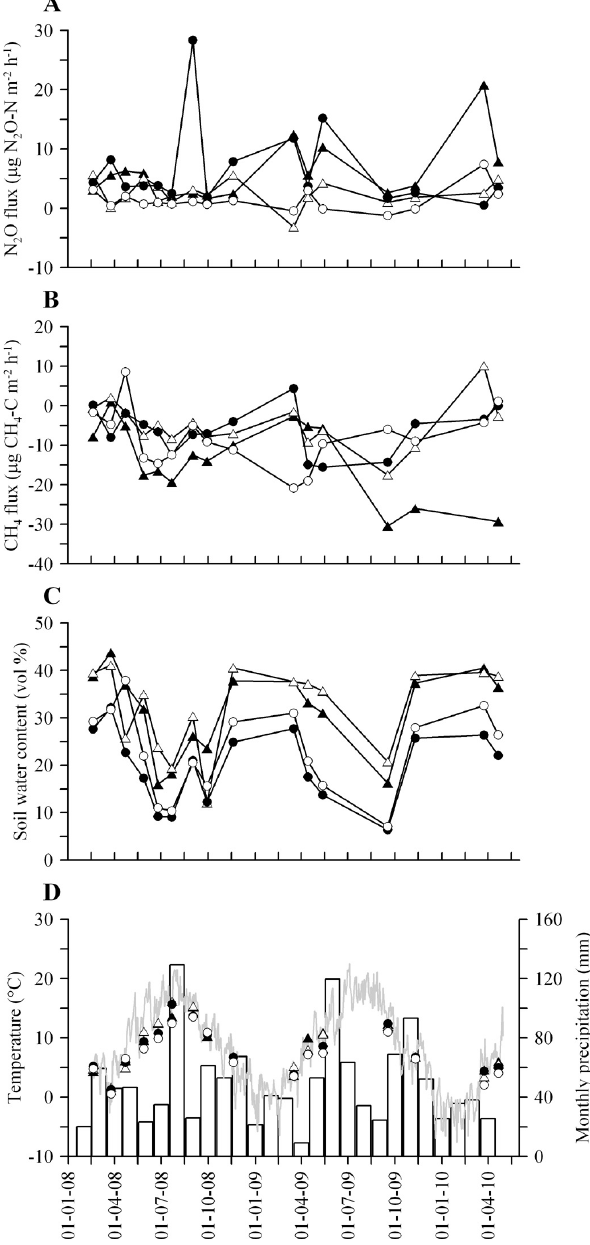
Fig. 1. Stand average (A) N 2 O flux (µg N 2 O-N m − 2 h − 1 ), (B) CH 4 flux (µg CH 4 -C m − 2 h − 1 ), (C) soil water content (vol%) and (D) soil temperature ( ◦ C) in 0–5cm (symbols), monthly precipi- tation in mm (bars) and average daily temperature in ◦ C (grey